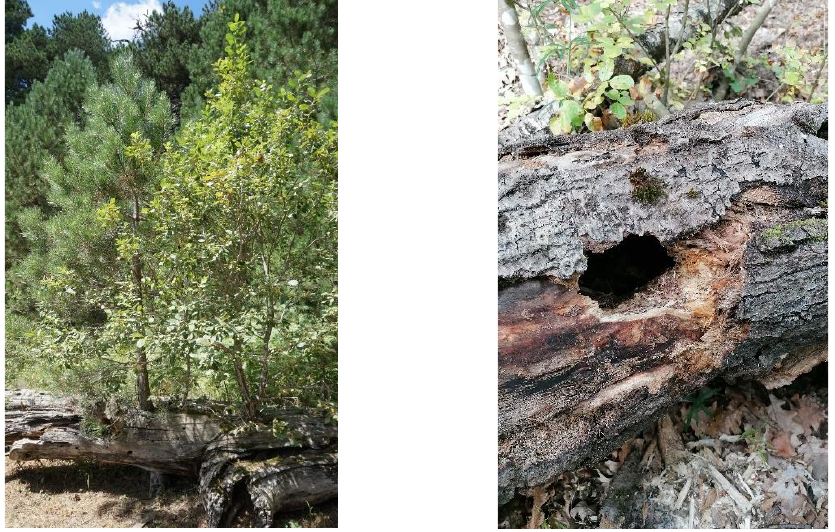
Figure 2. Deadwood provides a favorable environment for the regeneration of plant species and natural shelters for animals.